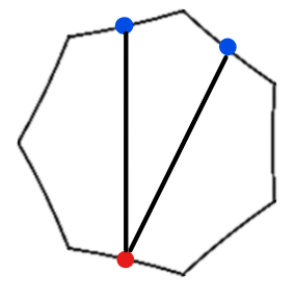
Figure 29 . In b = 7, so for a given red midpoint there are two blue midpoints which are the